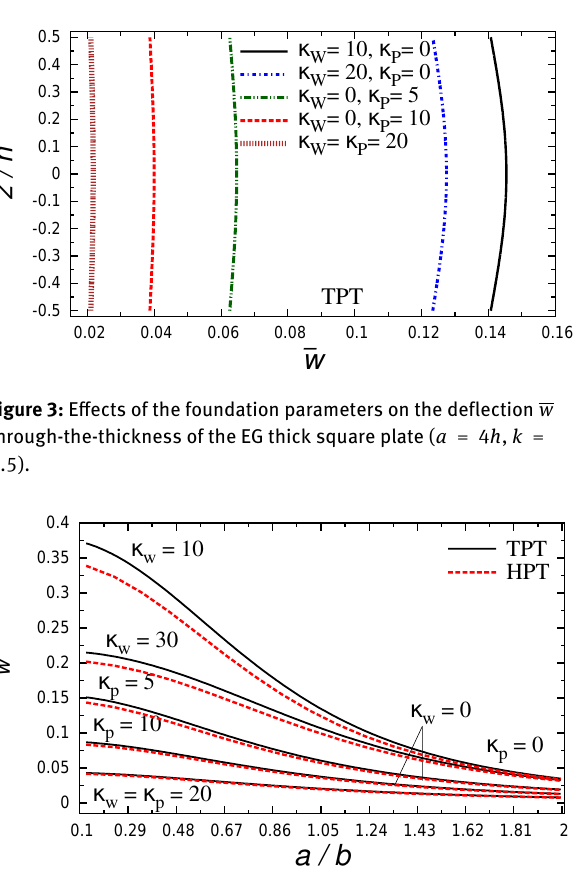
Figure 4: Effects of the foundation parameters on the deflection w versus the aspect ratio a / b of the EG plate ( z = 0, a = 4 h , k = 1.5) . 380 GPa. Table 3 gives a comparison of the deflection 10 2 D w ( a , b , 0) of an isotropic square plate on one param- 2 2 q 0 a 4 eter elastic foundation under uniformly distributed